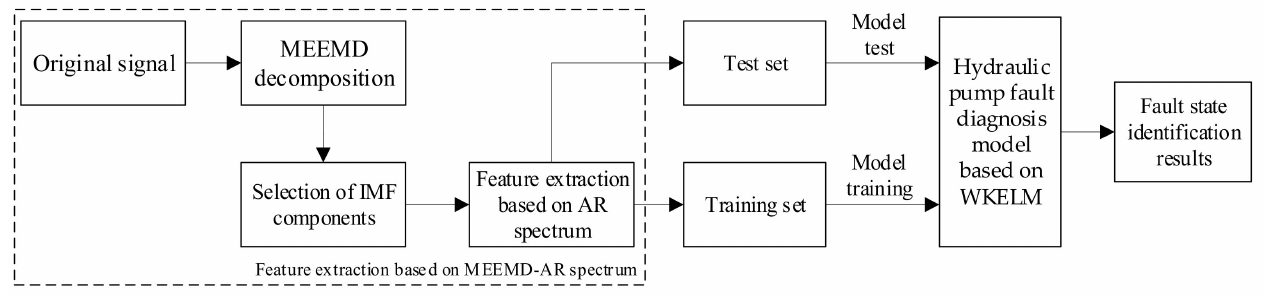
Figure 14. Fault diagnosis flow chart based on the MEEMD–AR–WKELM integration